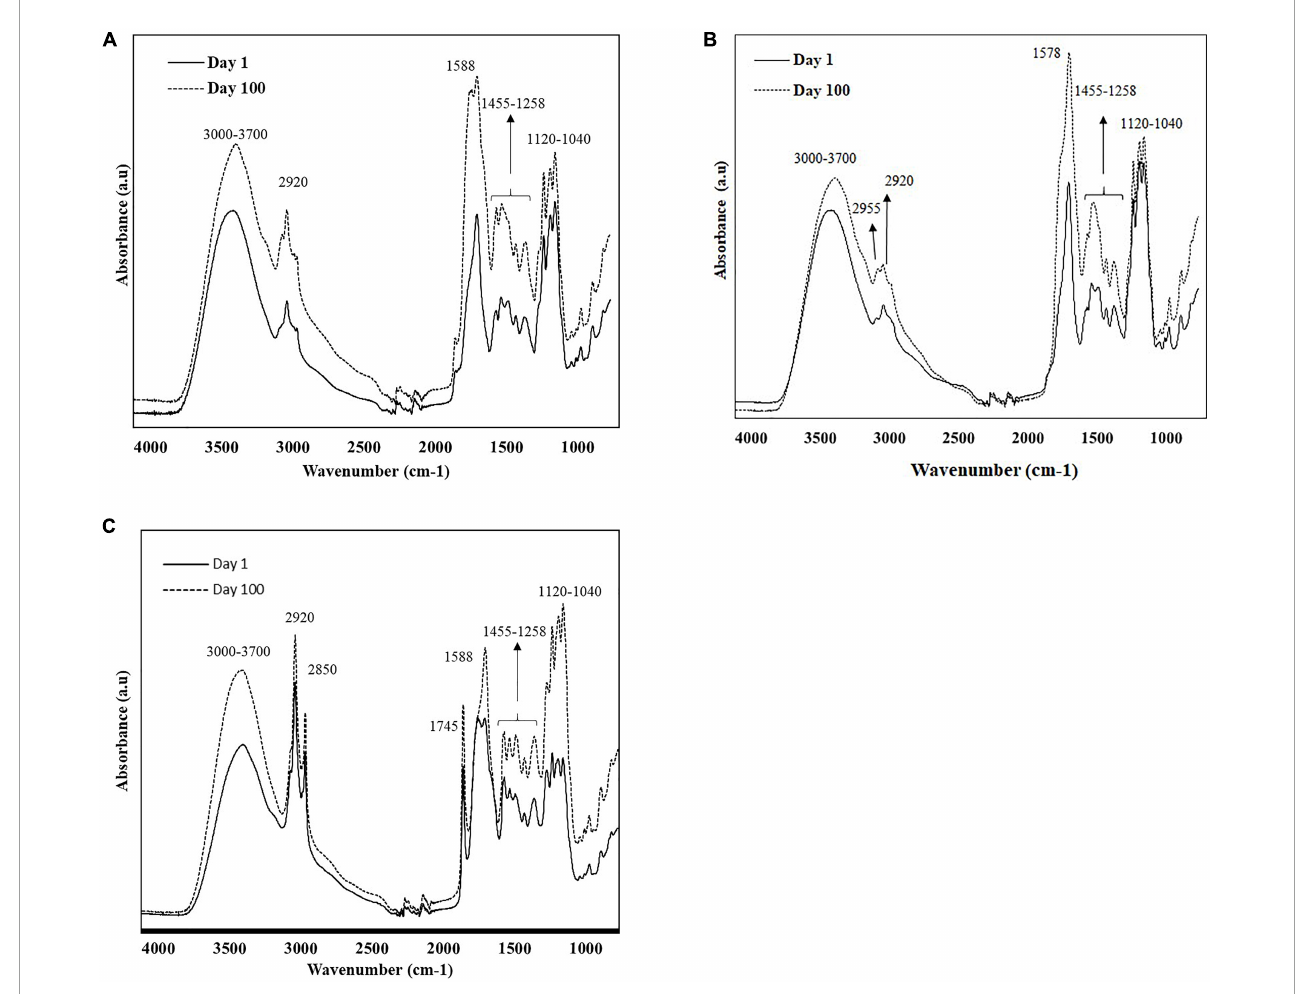
FIGURE1 Characteristic raw spectra of soluble extracts of cheese samples (A) water; (B) methanol; and (C) ethanol on day 1 and 100, were collected using portable FT-IR (4,000-650 cm − 1 ).